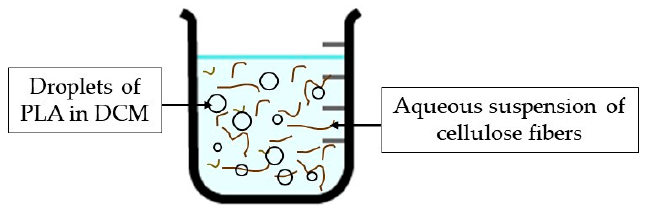
Figure 1. Illustration to show the oil-in-water emulsion in the process to obtain the PLA/cellulose biocomposite